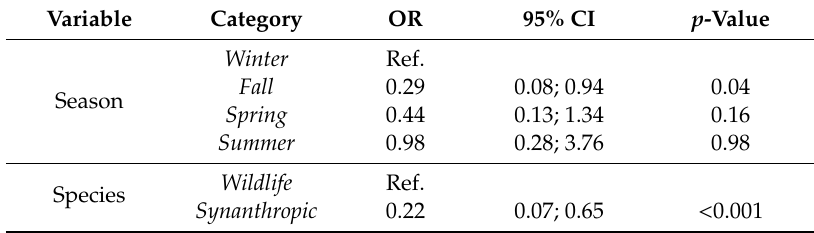
Table 9. Conditional mixed-logistic regression model results showing risk factors for rodents infected by pathogenic Leptospira spp. and trapped in dairy farms in the Los R í os Region, Chile. Variable Category OR 95% CI p -Value Winter Ref. Fall 0.29 0.08; 0.94 0.04 Season Spring 0.44 0.13; 1.34 0.16 Summer 0.98 0.28; 3.76 0.98 Wildlife Ref. Species Synanthropic 0.22 0.07; 0.65 < 0.001 Akaike Information Criteria (AIC) =